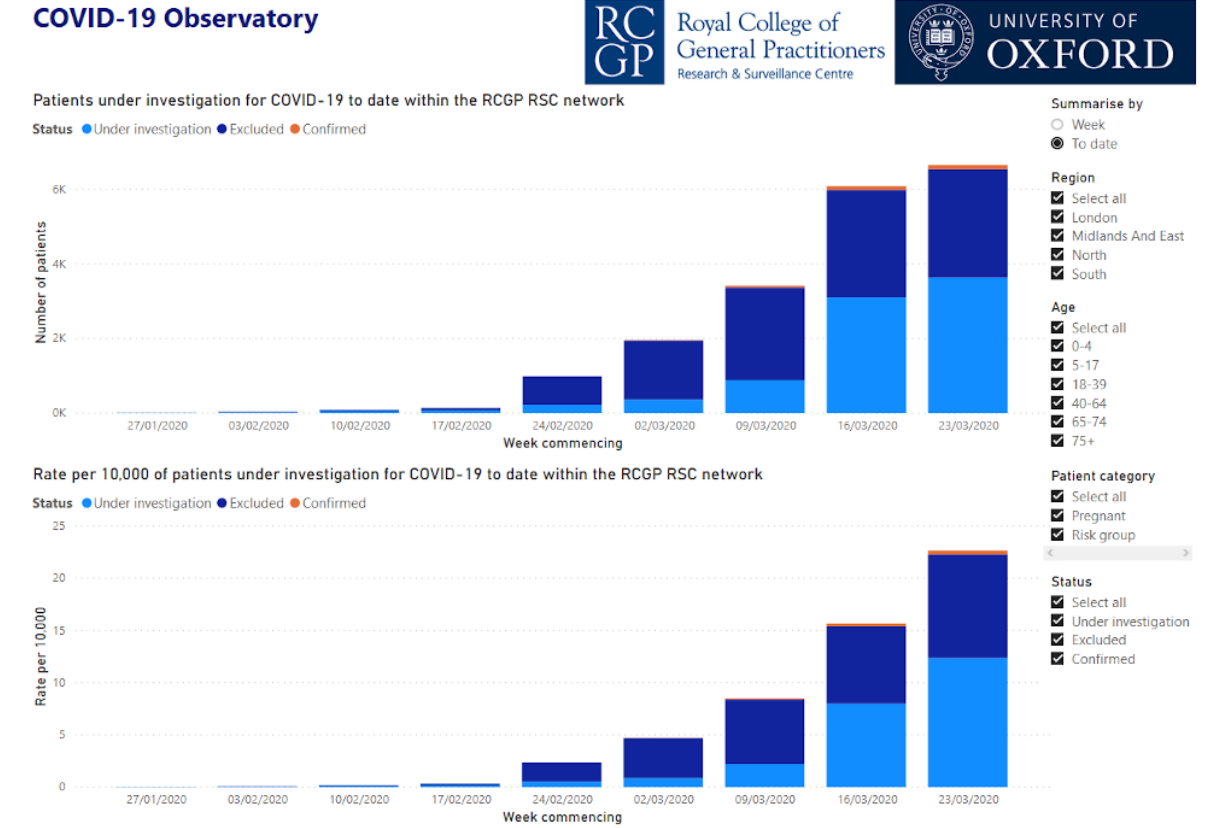
Figure 5. Screenshot of COVID-19 Observatory showing number and rate per 10,000 patients investigated for COVID-19 to date within the RCGP RSC